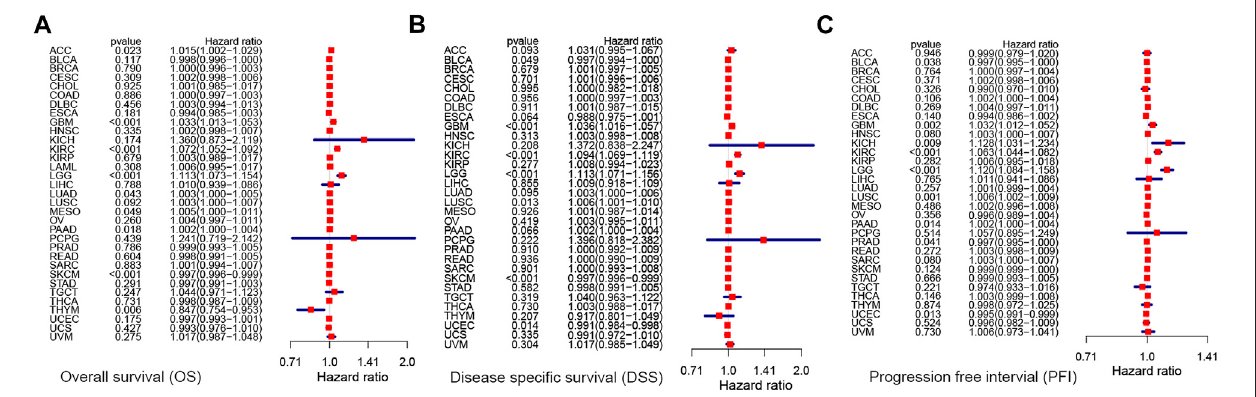
FIGURE 5 | Correlation between KCNN4 expression level and survival indicators as determined through univariate Cox analysis. (A) Univariate Cox analysis of the correlation between KCNN4 expression level and OS. (B) Univariate Cox analysis of the correlation between KCNN4 expression level and DSS. (C) Univariate Cox analysis of the correlation between KCNN4 expression level and